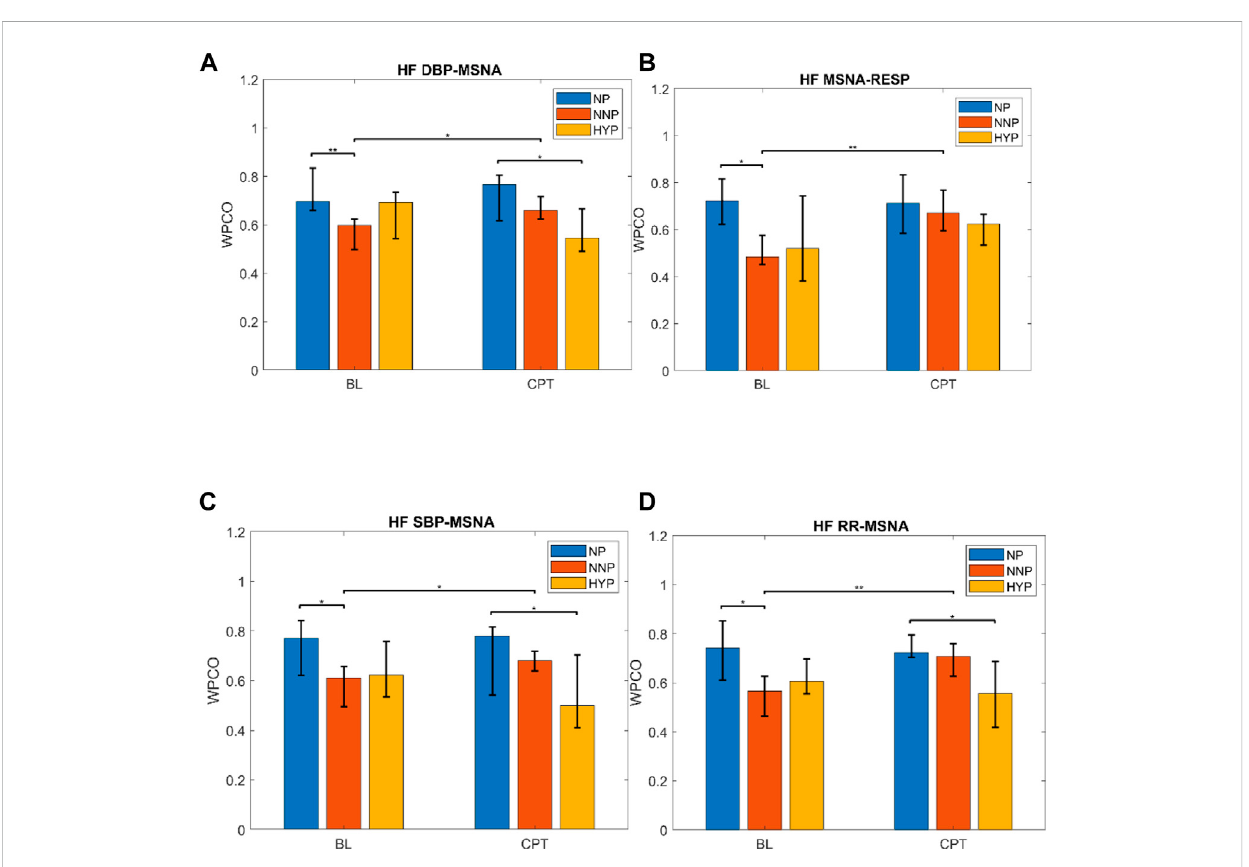
FIGURE 7 Wavelet phase coherence (WPCO) results for normotensive pregnant women (NP), normotensive non-pregnant women (NNP), and hypertensive pregnantwomen(HYP)intermsofmedianand95%CIduringbaseline(BL)andcoldpressortest(CPT).ResultsshowWPCObetweenmusclesympathetic nerveactivity(MSNA)anddiastolicbloodpressure (A) ,MSNAandrespiratorywave(RESP) (B) ,MSNAandsystolicbloodpressureSBP (C) ,andMSNAandRR interval (D) in the high-frequency band (HF). * Represents p < 0.05. ** represents p <